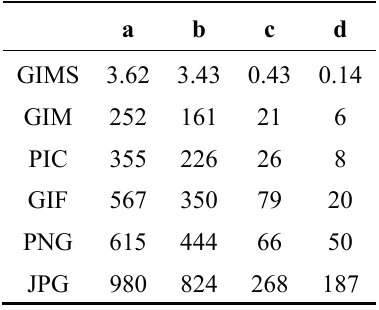
Table 2. Comparison of compression methods, number are file sizes in